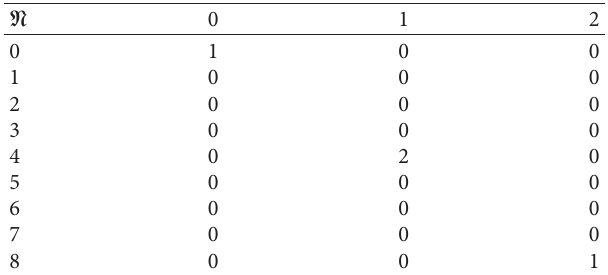
Table 1: Graded Betti numbers of N .